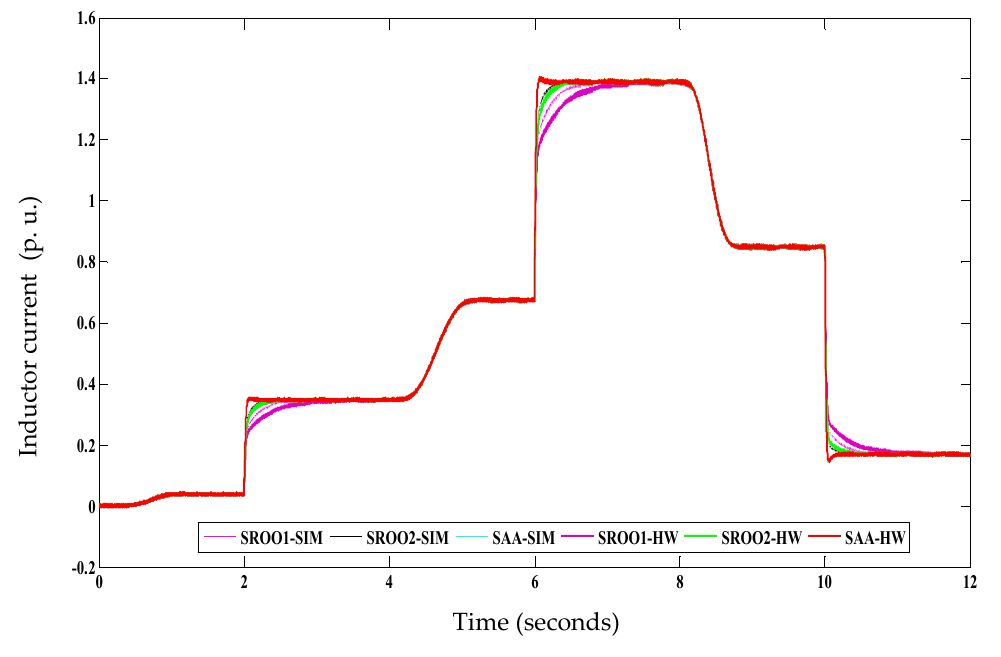
Figure 8. Inductor current of the Luo converter. Electronics 2020 , 9 , x FOR PEER REVIEW